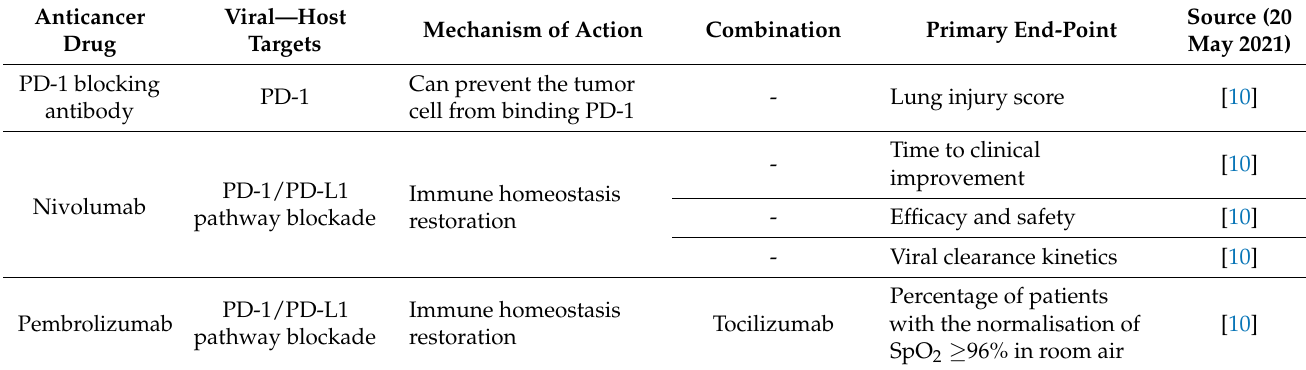
Table 3. Anticancer drugs in clinical trials for COVID-19: Immune-checkpoint inhibitors.